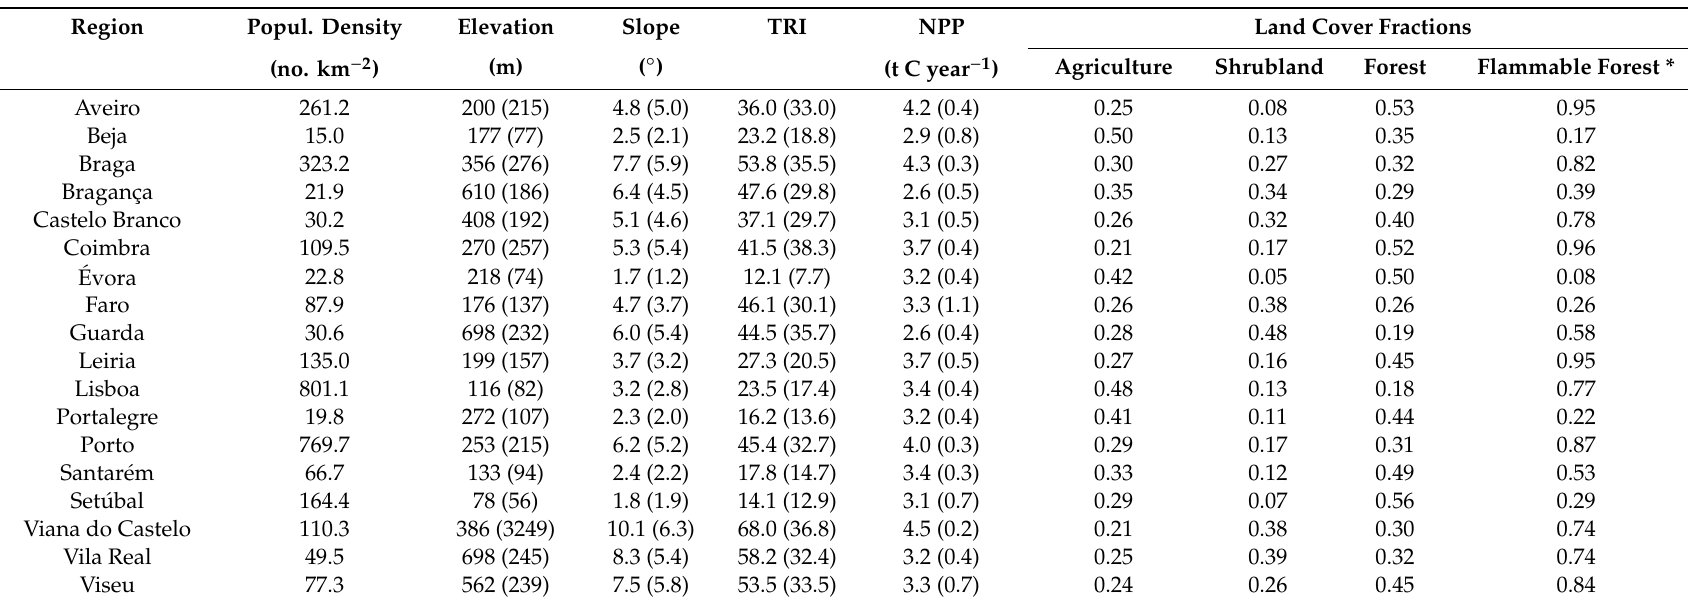
Table 1. Regional means (standard deviations) of variables expected to influence the relationships between fire activity and fire weather in Portugal. TRI is the topographic ruggedness index and NPP is net primary